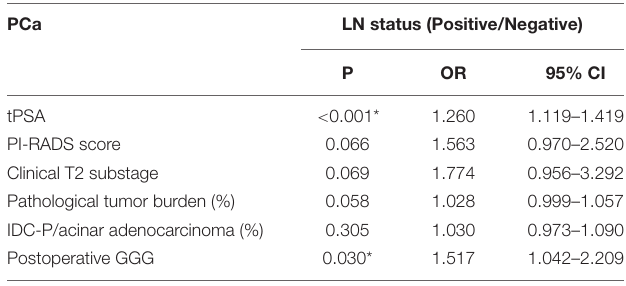
TABLE 2 | Multivariate logistic regression analysis of risk factors for LN invasion in all patients.